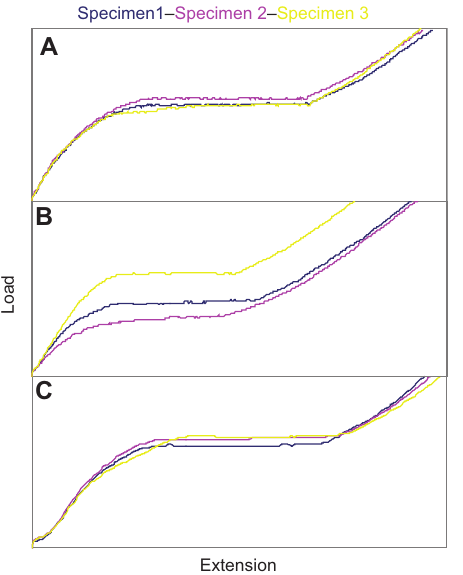
Figure 2 Effect of displacement rate on 1 mm diameter wire of length 100 mm. (A) 2 mm/min, (B) 4 mm/min and (c) 15 mm/min.